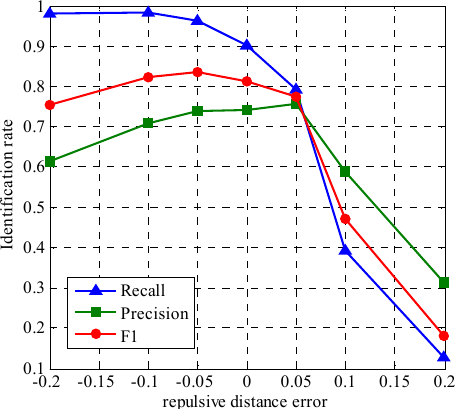
Figure 9. Identification rate for different estimation errors of the repulsive distance.